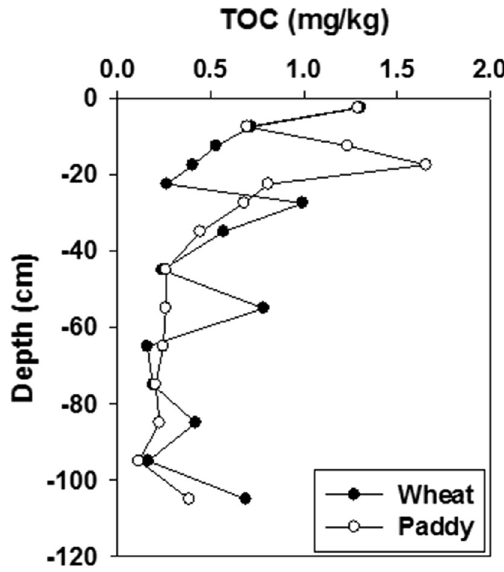
Fig. 6 Variation of TOC concentrations with depth along paddy and wheat soil